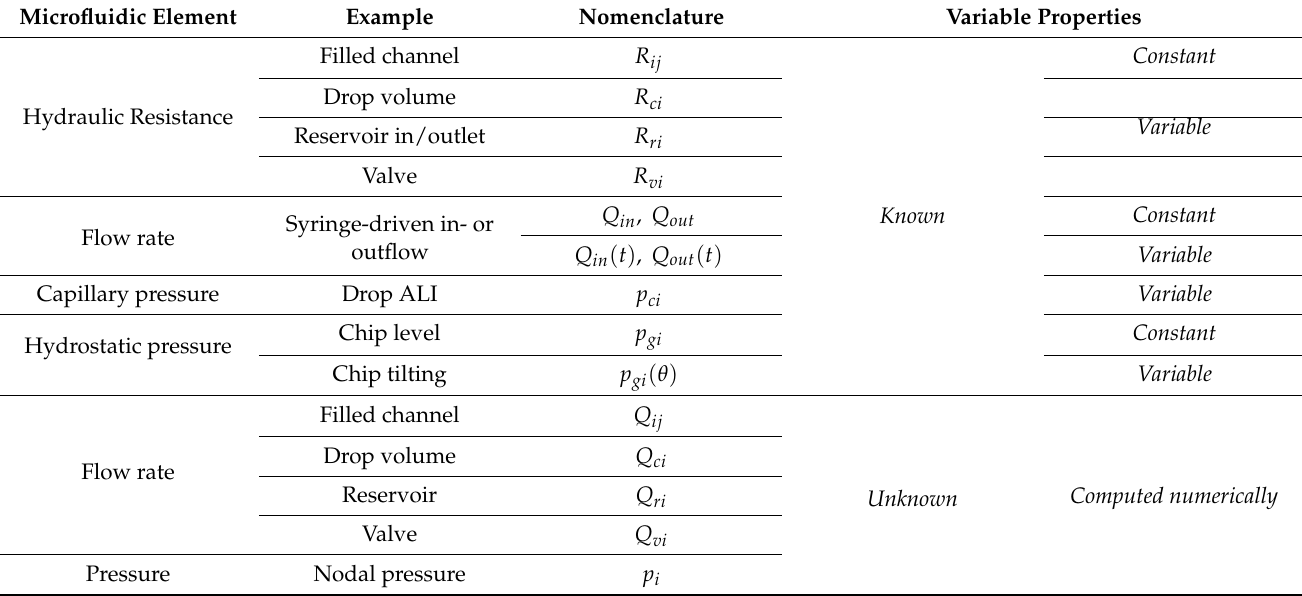
Table 3. Variable definition for each microfluidic element. Subscripts in the nomenclature are descriptive of the element, where c, r , v , and g denote capillary, reservoir, valve, and gravity. Subscripts are also enumerative, where i denotes the i ’th node, ij denotes an element between the i ’th and j ’th nodes, and in and out denote the inlet and